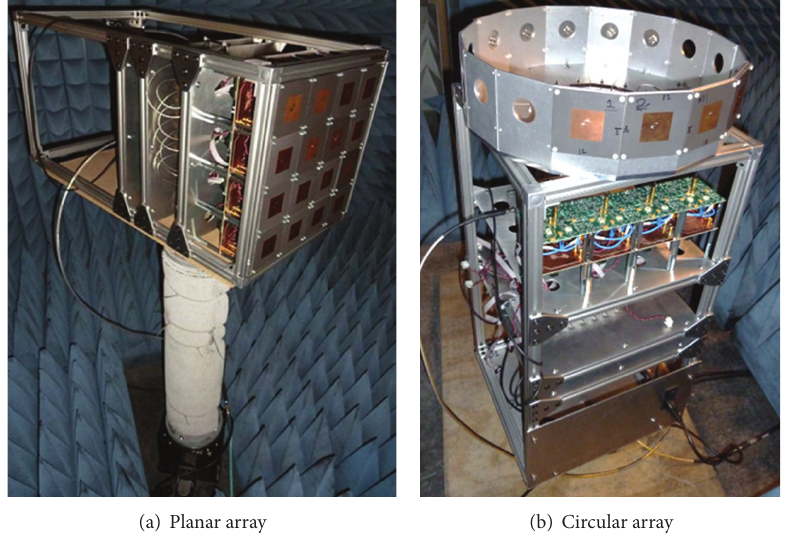
Figure 7: The CPAD is mounted on the rotary stage for antenna